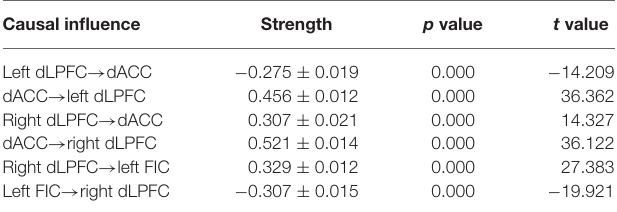
TABLE 2 | Statistical analysis of the resting-state effective connectivity of the winning spDCM model—the strength of the effective connections were analyzed using one-sample t -tests